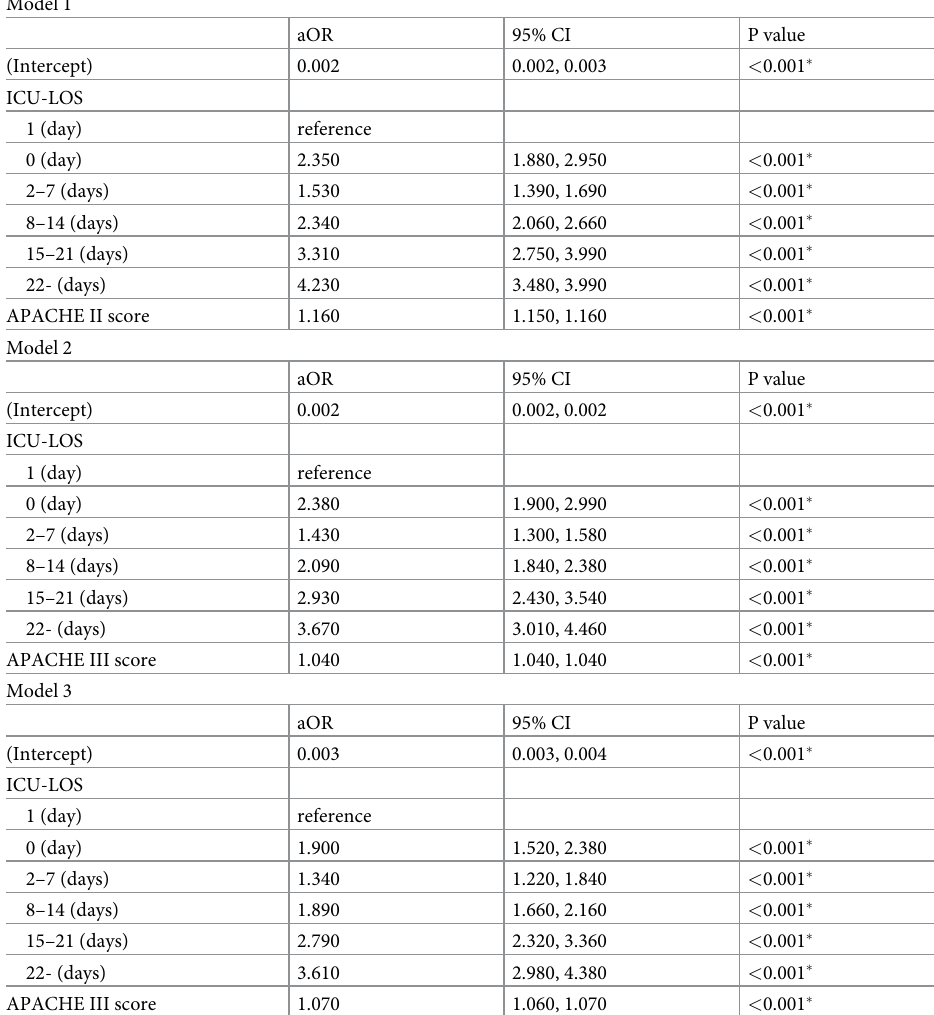
Table 6. Multivariate logistic regression model to predict hospital-death after adjusting severity